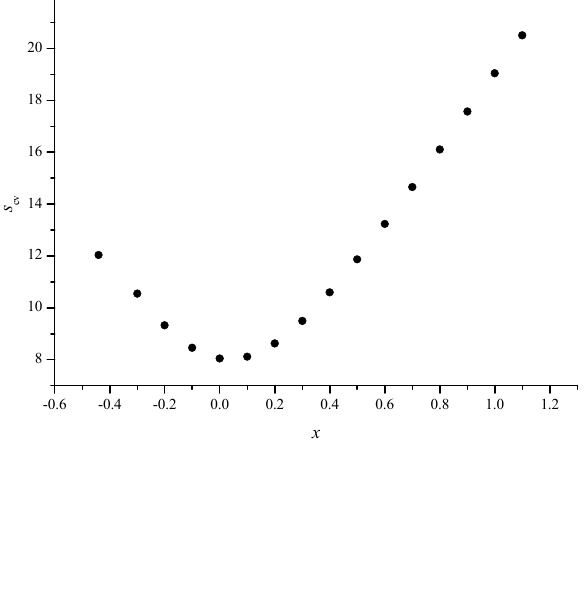
Figure 5. Scatter plot between the cross validated standard errors of estimate ( S and x values in the range from –0.4 to +1.1 for the optimum value of y